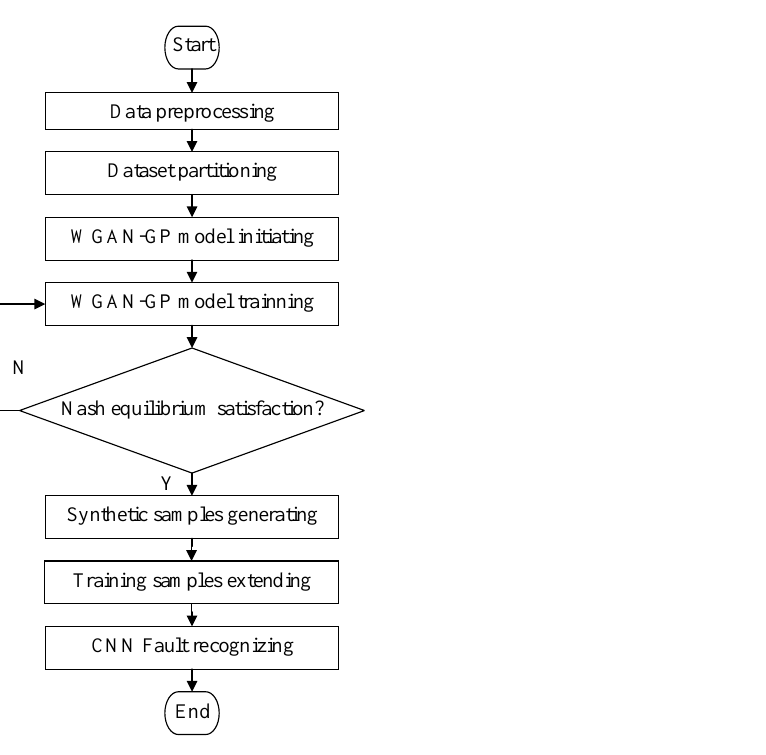
Figure 2. The flow chart of the DWGANGP model.